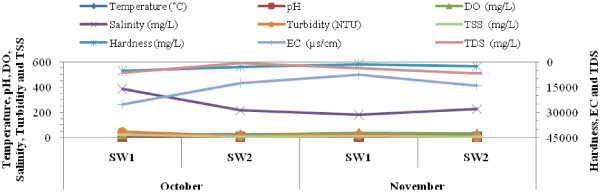
Water parameters measured during sampling in the selected sites of the Shadegan international wetland from the late October to late November 2011.